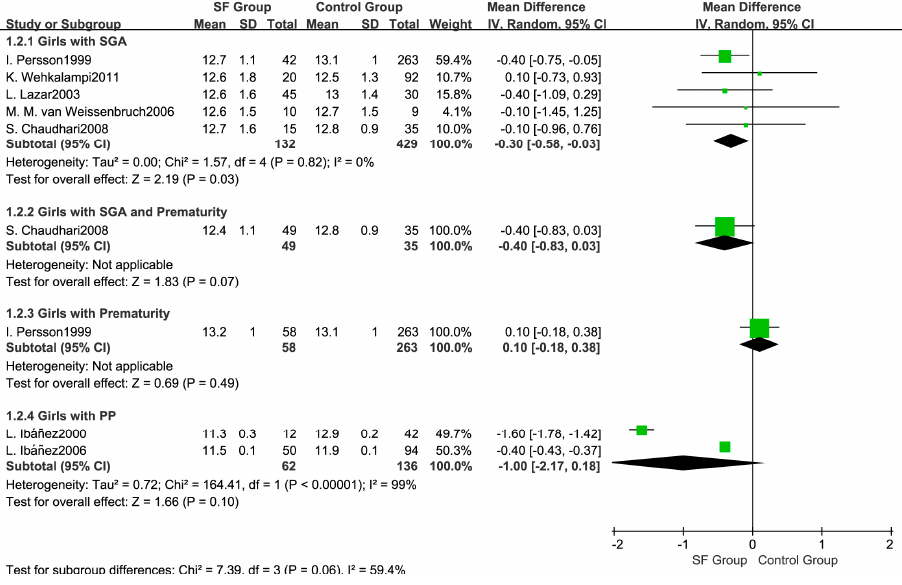
Figure 7. Forest plot for subgroup analysis on age at menarche between SF group and Control group.